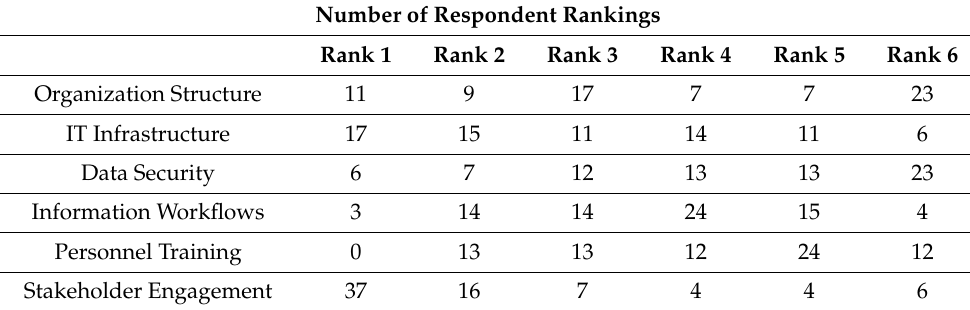
Table 2. Number of responses ranking the implementation factors.